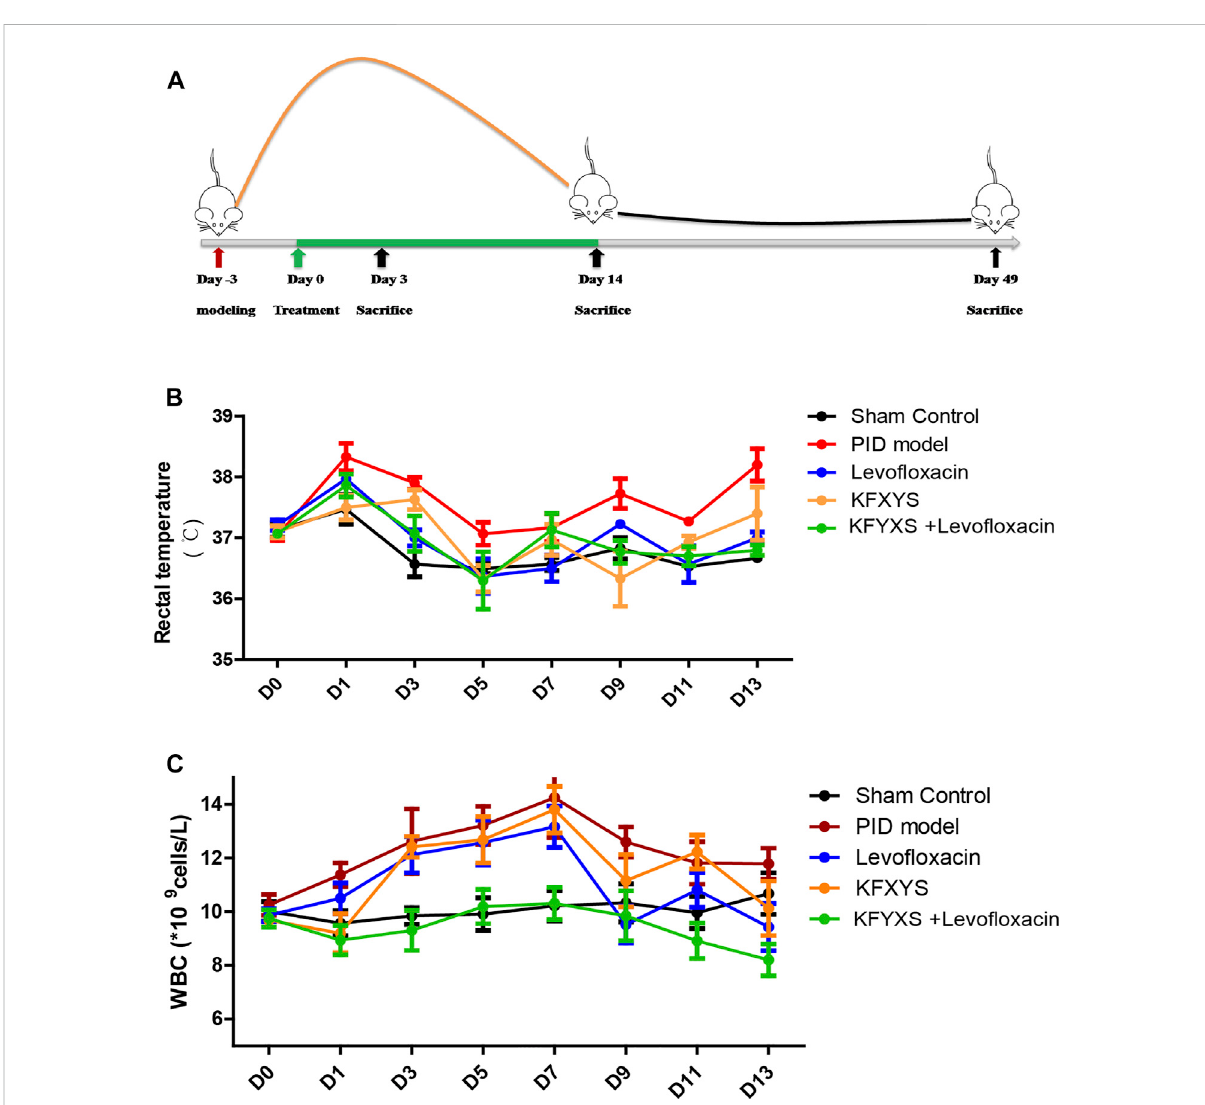
FIGURE 1 Schematic diagram of the experiment and changes in rat rectal temperature and WBC counts after treatment with different drugs. (A) Schematic diagram of the experimental setup. The fi rst treatment day was denoted as D0.At D3, rats received 6 × 10 8 CFU E. coli and S. aureus solutionsandunderwentendometrialscratching.Treatmentcontinuedfor14days,andtissuesweresampledatD3,D14andD49. (B) Thechangesin the rectal temperature of the rats during 14 days of treatment. The mean ± SEM are plotted in the graph; n = 4. (C) The infection indices and WBC counts determined fromsamplestaken from theeyeballs of therats during 14 days of treatment. The mean ± SEM areplottedinthegraph; n = 7. Sham control: rats received laparotomy without manipulation and treatment. PID model: rats were untreated following the PID operation. Levo fl oxacin:ratsthatreceived50mg/kg/day levo fl oxacinorallyfor14days followingtheoperation.KFXYS:ratsthatreceived400mg/kg/dayKFXYS rectally for 14 days following the operation. KFXYS + Levo fl oxacin: rats that received 400mg/kg/day KFXYS rectally and 50 mg/kg/day levo fl oxacin orally for 14 days following the